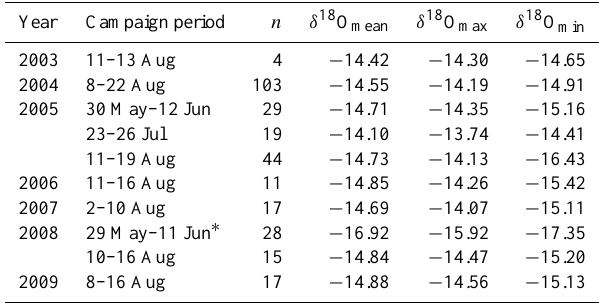
Table 1. Summary of δ 18 O mean and range in bulk water samples at the Mittivakkat Gletscher